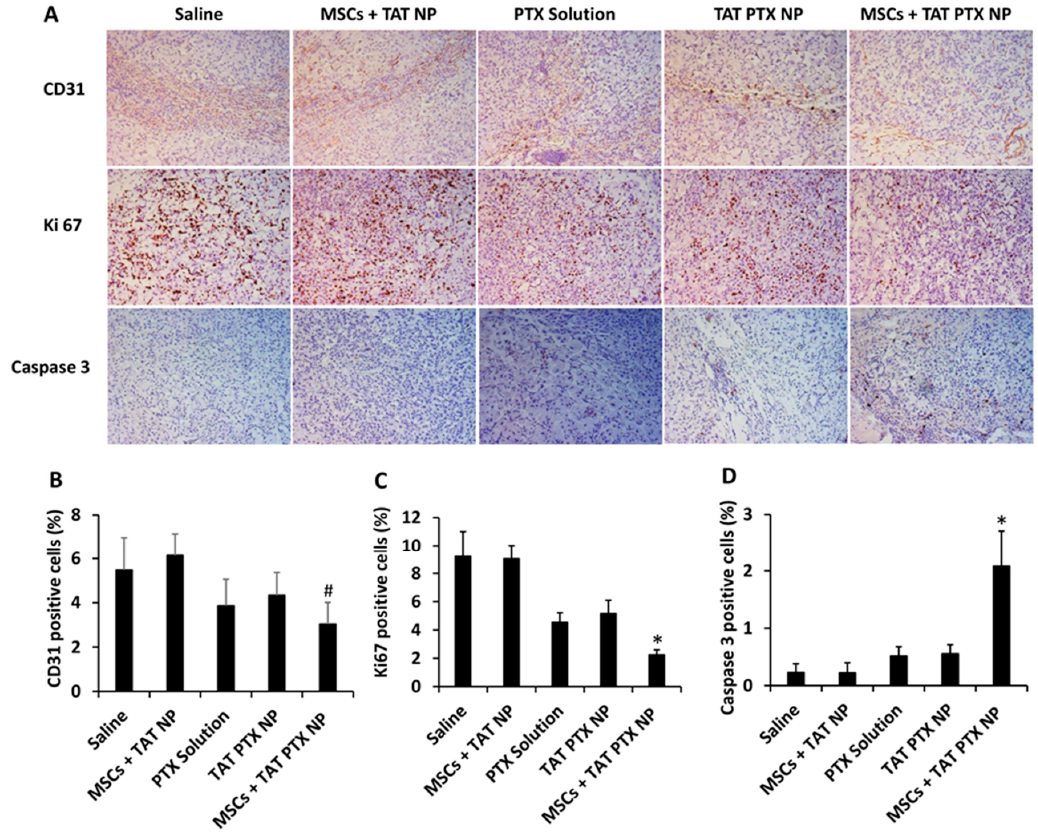
Figure 4. Immunohistological analysis of lung tumors collected from therapeutic efficacy study. ( A ) Lung tumors were stained for CD31 (angiogenesis marker), Ki-67 (proliferation marker), and caspase-3 (apoptosis marker). Images were taken at 20× magnification. Quanti fi cation of ( B ) CD31, ( C ) Ki67, and ( D ) cleaved caspase-3 staining. Data represented as mean ± SD, n = 9 images; * p < 0.05 compared with other treatment groups and # p < 0.05 compared with saline and MSCs + TAT NP.